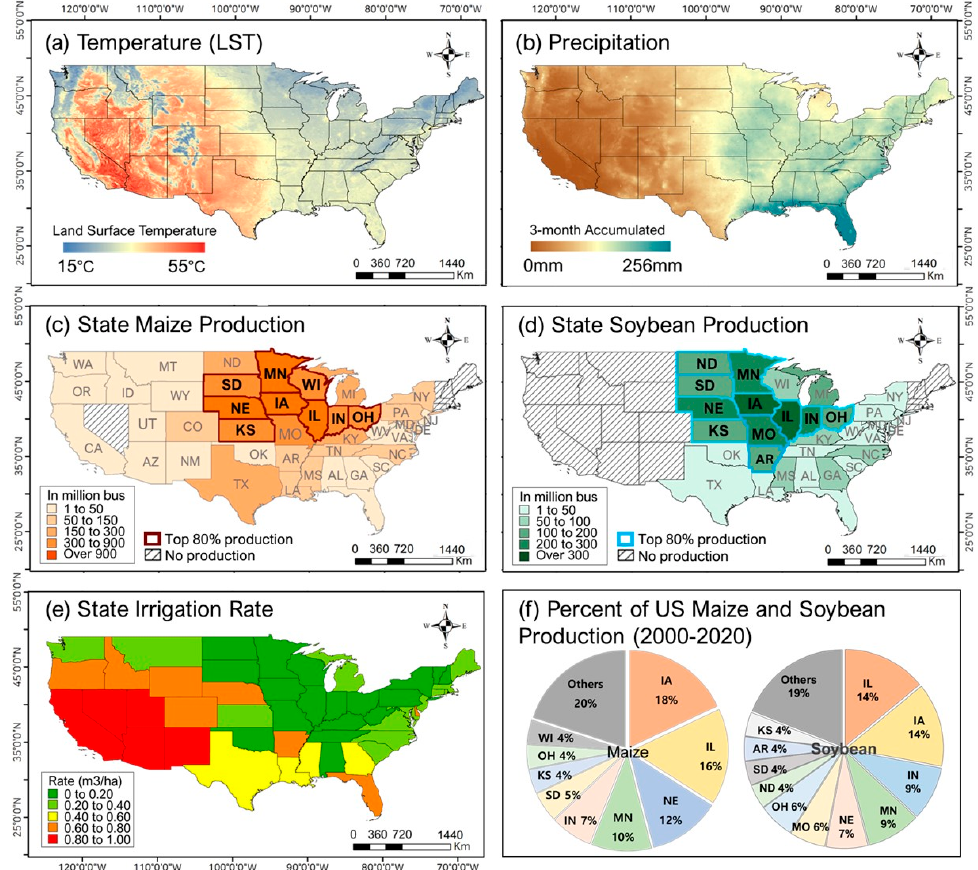
Figure 1. The spatial distribution of mean LST and precipitation for July–August ( a , b ), the amount of state maize and soybean production, and the average irrigation rate for the state ( c – e ), and the percentage of US maize and soybean production indicated for each state ( f ).